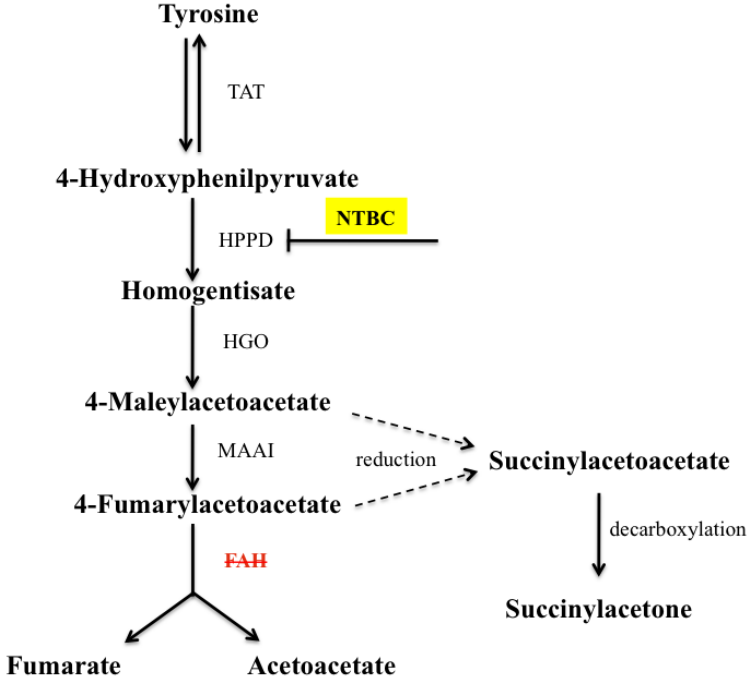
Figure 1. The five enzymatic steps of tyrosine catabolism and NTBC site of